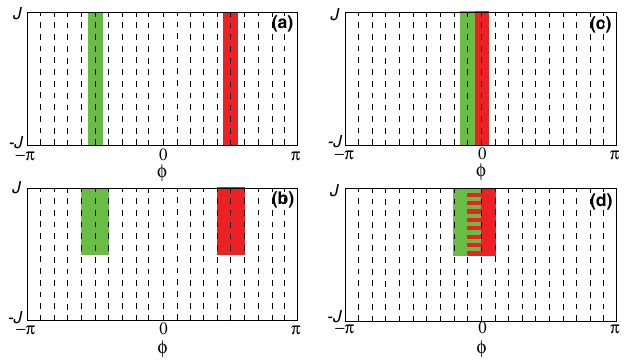
FIG. 11. Schematic Wigner functions for the mixtures of two- phase eigenstates for D ¼ 20 . (a) The worst permutation; cf. Fig. 8(c). We have rotated the entire sphere by (cid:4)= 2 about z to simplify the explanation of the speeding-up. (b) The worst permutation after a positive measurement result (modulo (cid:4)= 2 ). The total area is constant in (a) and (b), and it is equal to 4 (cid:4) . (c) The optimal permutation; cf. Fig. 8(b). (d) The optimal permutation after a positive measurement result. The total area is reduced in (d) to 3 (cid:4) , which gives rise to a purifying effect. (The purity is inversely proportional to the area underneath the Wigner function.) The striped region (cid:9) 2 ð(cid:2) (cid:4)=D; 0 (cid:6) denotes that the red and green rectangles are overlapping in this